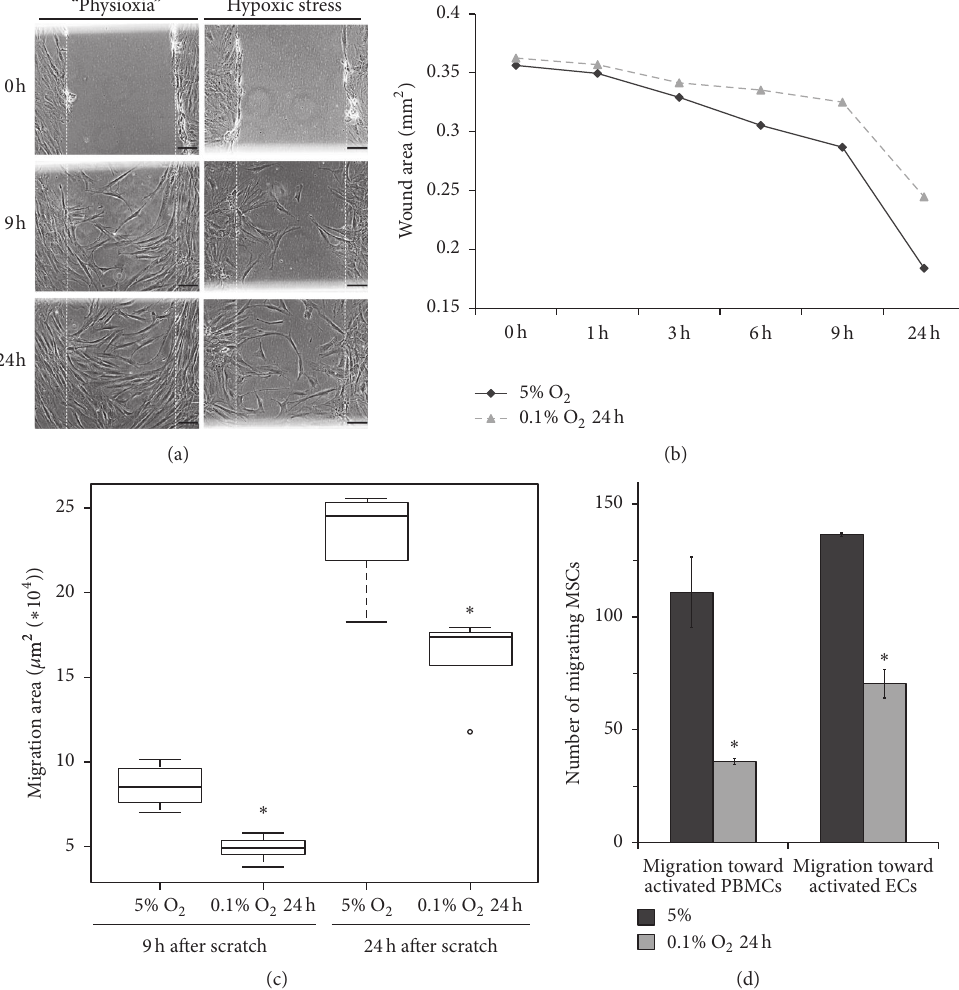
Figure 3: Adipose tissue-derived mesenchymal stromal cell (ASC) migration in scratch ((a)–(c)) and transwell (d) assays. (a) Representative phase-contrast images of the in vitro wound-healing assay (scale bar, 100 𝜇 m). Monolayers of cells cultured at 5% O 2 or after short-term hypoxic stress (0.1% O 2 , 24 h) were scraped, and images were taken at 0, 1, 3, 6, 9, and 24 h. The dotted lines define the areas of scratches. (b) Representative curves of time-dependent wound closure ( 𝑛 = 5 ). (c) Statistical analysis of migration results ( ∗ 𝑝 < 0.05 , 𝑛 = 5 ). (d) Targeted migration of ASCs was analysed in transwell assay. The tissue O 2 -adapted ASCs before and after hypoxic stress were seeded on a membrane in the upper chamber and allowed to migrate for 24 h towards phytohemagglutinin-activated peripheral blood mononuclear cells (PBMCs) or TNF 𝛼 -activated endothelial cells (ECs) cultured in the lower chamber. The migration rate was defined as a number of migrated ASCs ( ∗ 𝑝 < 0.05 , 𝑛 = 3